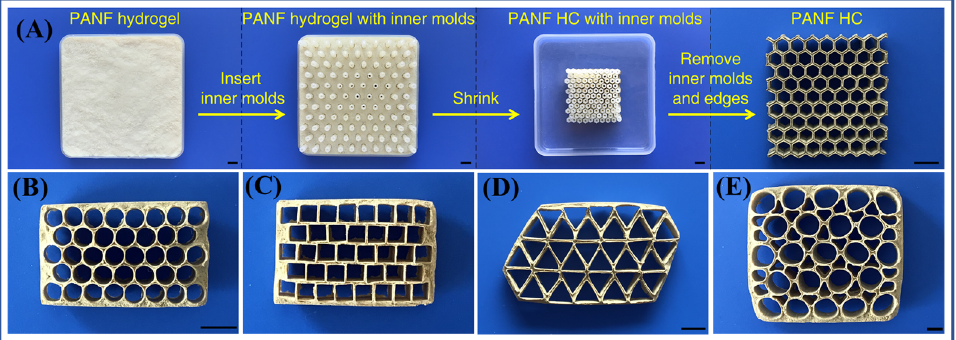
Figure 10. ( A ) The preparation process of PANF honeycomb (HC); scale bars: 10 mm [43]; ( B – E ) PANF HCs with different round, square, triangular and irregular cells, respectively; scale bars: 10 mm [43]. Copyright 2021 John Wiley and Sons.